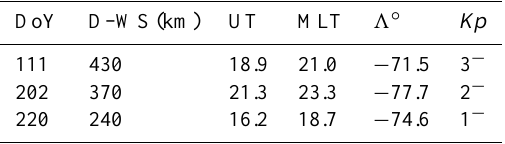
Table 2. Comparison of wave properties of earlier and current work. Table 3. Calculated Davis–wave source distance (D-WS), approxi- mate mid-time of wave generation (UT and MLT), magnetic latitude of source, and Kp at